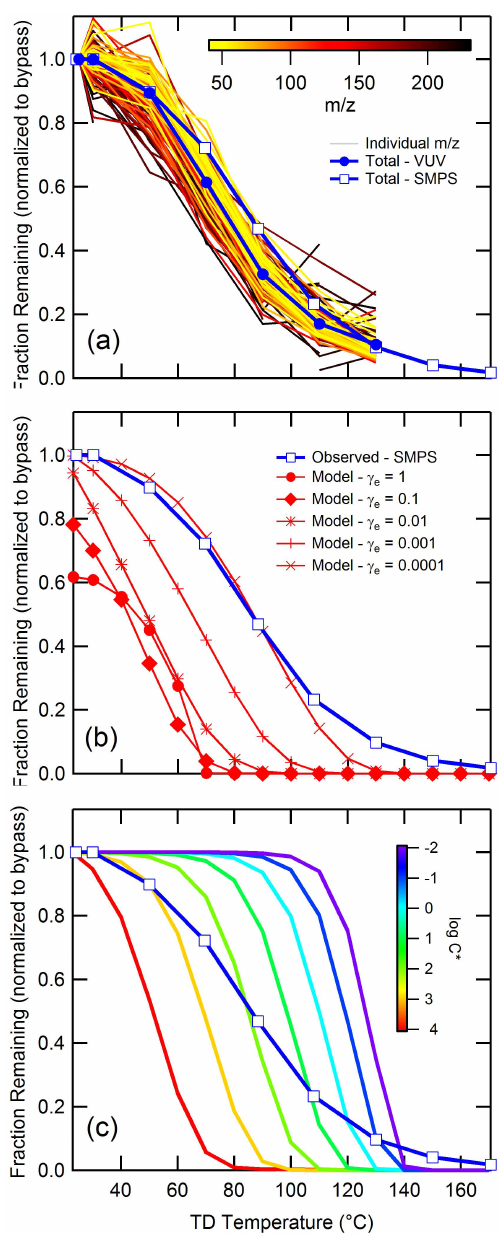
Fig. 5. (a) The measured individual peak thermograms over the range m/z =42–230 are shown (see color scale) along with the aver- age peak (blue • ) thermogram and the SMPS-derived mass thermo- gram (blue (cid:3) ) for α P particles. (b) Calculated mass thermograms for low-NO x α P aerosol are shown for different assumed γ evap val- ues (see legend). The observed total mass thermogram is shown for reference. (c) Calculated thermograms for the individual C ∗ com- ponents assuming that γ e = 10 − 4 , indicating that distillation would still be expected. Line colors correspond to component C ∗ values (see color scale). The observed total mass thermogram is shown for